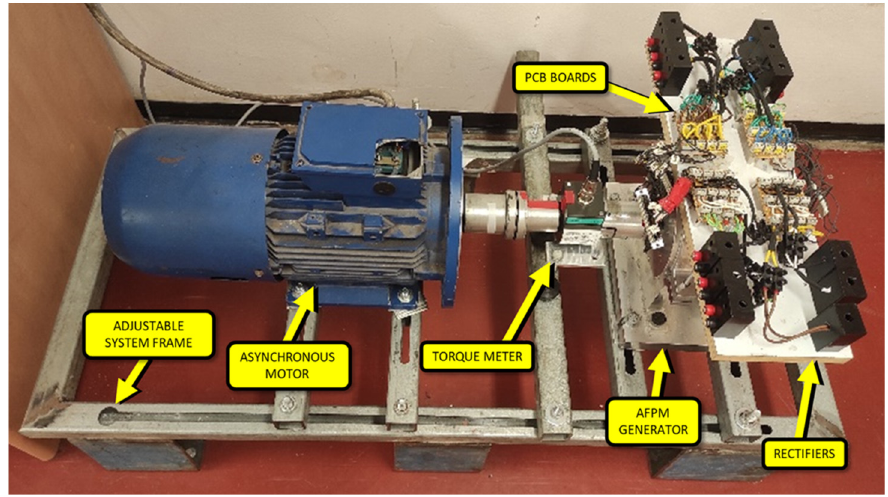
Figure 9. Complete setup of the experimental